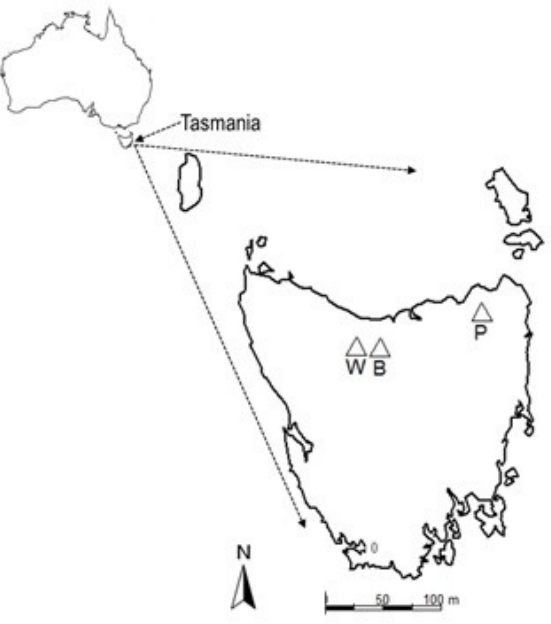
Figure 1. A map of Australia showing the location of Tasmania and the location of the three Pinus radiata family trials within Tasmania: P = Payanna; B = Beulah; and W =